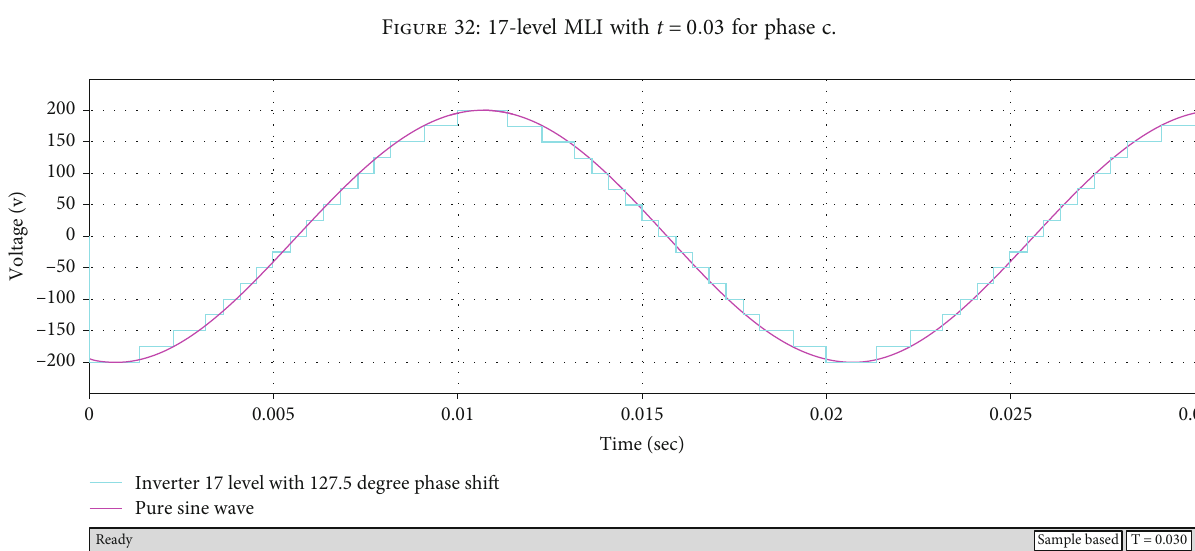
Figure 33: 17-level MLI with t = 0 : 03 for phase c and compared with sine wave.